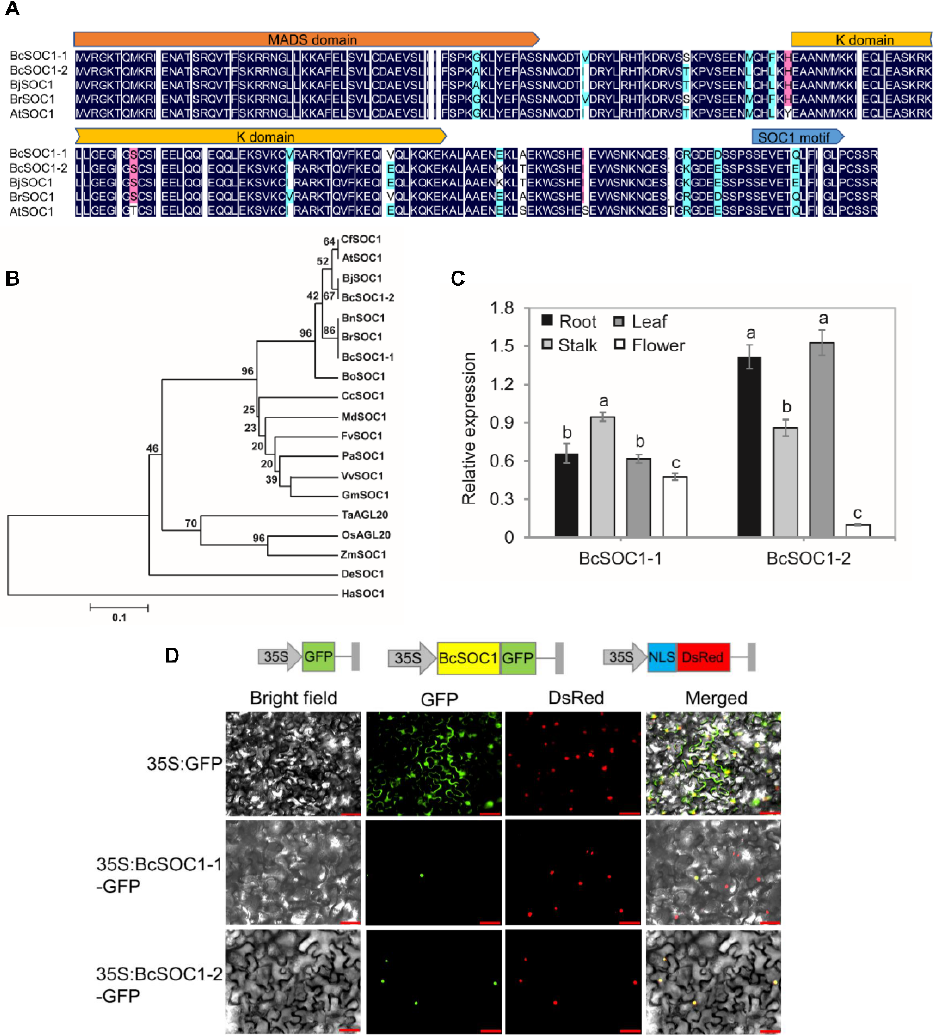
Figure 1. Sequence and expression analysis of BcSOC1 in flowering Chinese cabbage. ( A ) Amino acid sequence analysis of BcSOC1 and other SOC1-like proteins. BcSOC1 was used as the query sequence, and other SOC1-like proteins with highly similar sequences in Brassica juncea , B. rapa, and Arabidopsis thaliana were retrieved from the NCBI database. ( B ) Phylogenetic analysis of SOC1 sequences of different plant species was performed using the neighbor joining method in MEGA7, with 1000 bootstrap replicates. Bo: B. oleracea , Bn: B. napus , Bc: B. campestris , Cf: Cardamine flexuosa , Md: Malus domestica , Fv: Fragaria vesca , Pa: Prunus armeniaca , De: Dendrobium , Ta: Triticum aestivum , Os: Oryza sativa , Zm: Zea mays , Ha: Helianthus annuus , Gm: Glycine max , Vv: Vitis vinifera , Cc: Carya cathayensis . ( C ) Expression level of BcSOC1 in different tissues (a, b and c) of flowering Chinese cabbage. ( D ) Subcellular localization of BcSOC1 in Nicotiana benthamiana. Bar = 50 μ m.